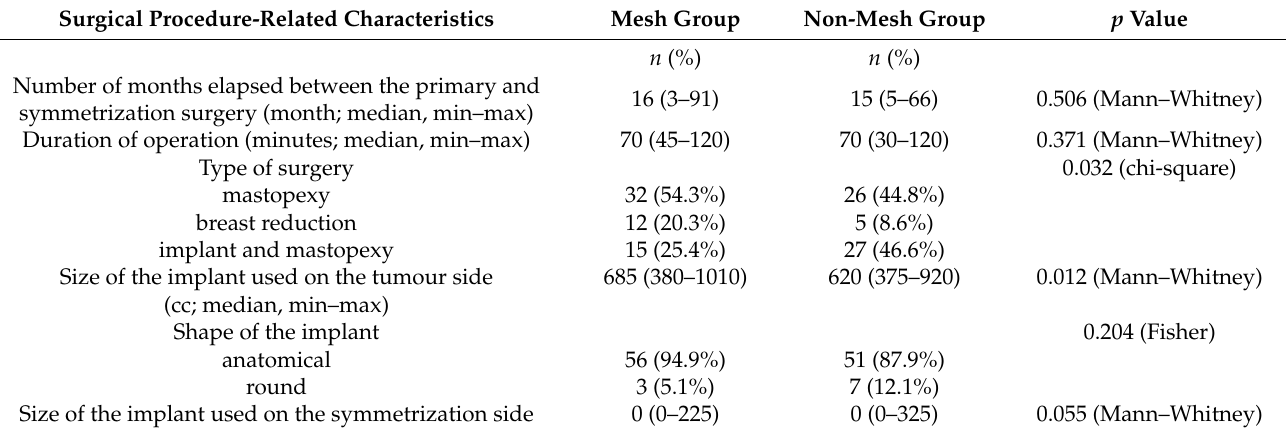
Table 2. The surgical procedure-related